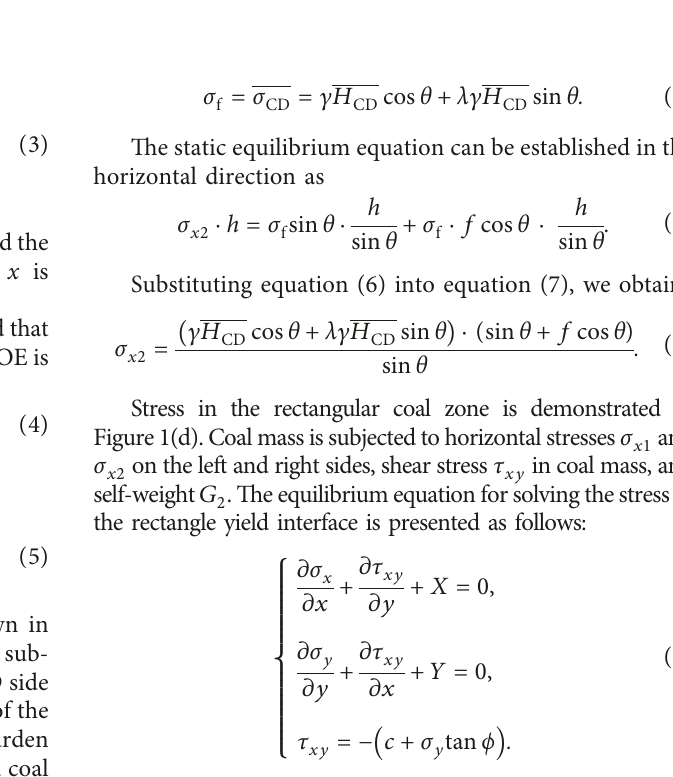
Figure 1: (a) Mechanical model for horizontal slice mining of the SICS. (b) Mechanical model for distribution of abutment pressure on the roof and stress of coal-rock in the working face. (c) Stress in the roof triangular zone. (d) Stress in the rectangular coal zone. (e) Stress in the floor triangular